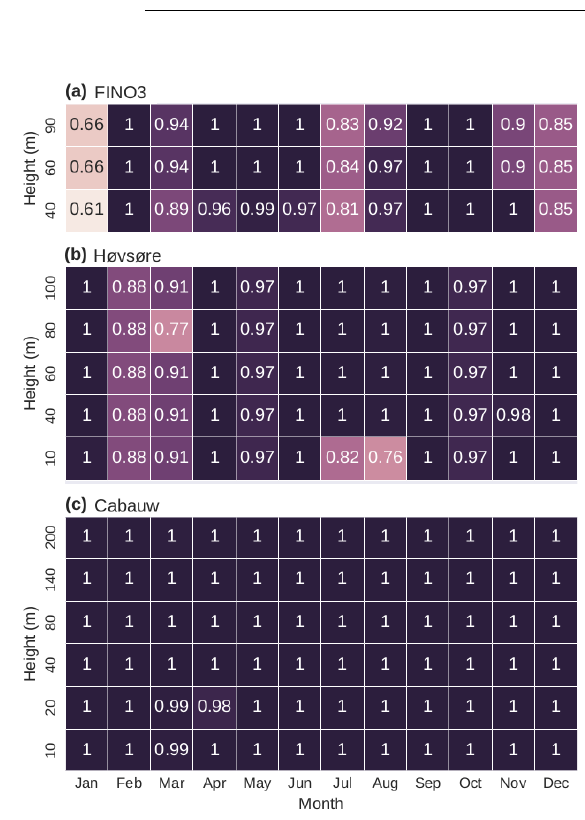
Figure 2. Availability of wind speed and direction observations for (a) FINO3, (b) Høvsøre, and (c) Cabauw given as the fraction of completeness for each month of the year 2011 for each